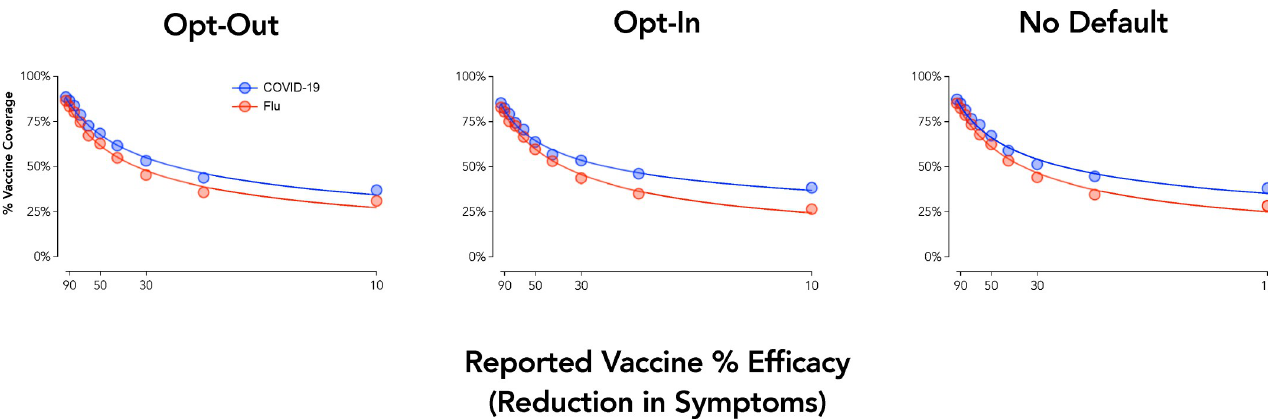
Fig 6. Vaccine acceptance by efficacy, type, and choice framing. Plotted are group discounting curves by vaccine type (COVID-19 = blue; flu = red). X axis values are computed as odds against symptom reduction. Curves are plotted using the hyperbolic discounting equation including a non-linear scaling parameter